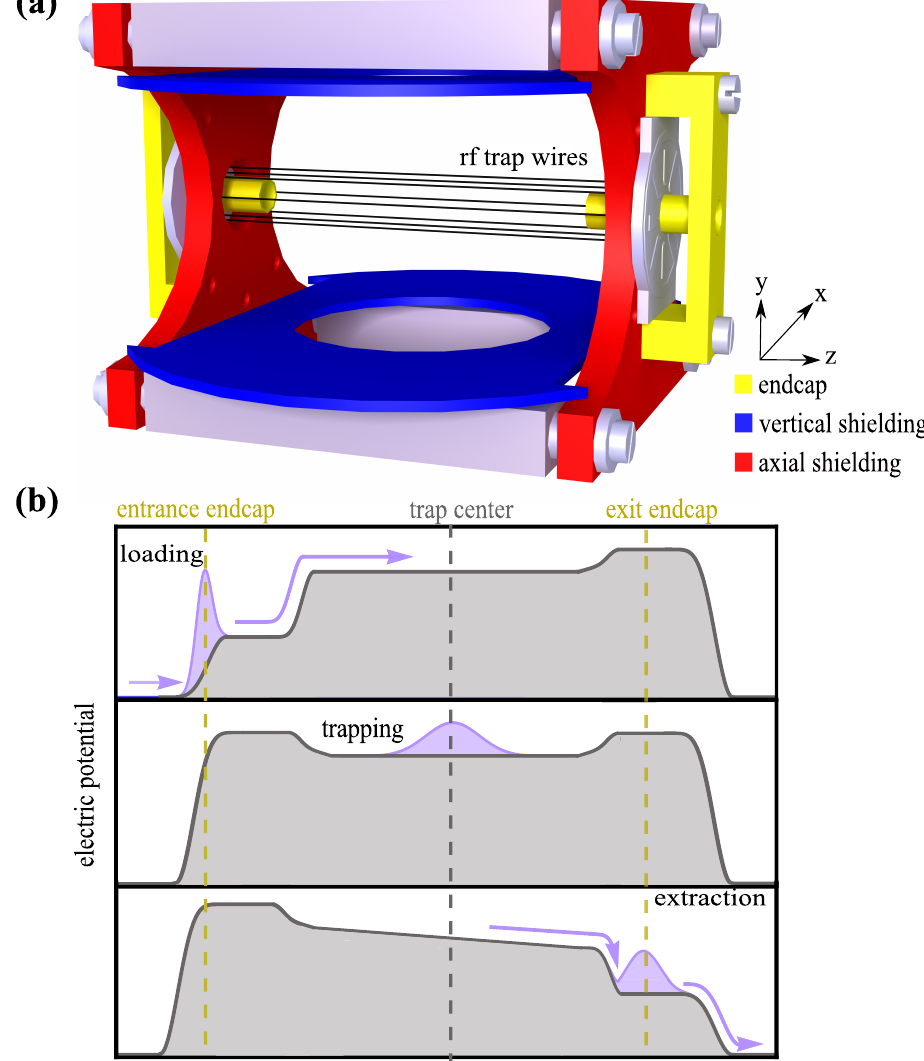
Figure 2. Description of the ion trap. ( a ) A 3D model of the ion trap is shown with an illustration of the radio frequency (rf) trap wires, endcap electrodes, and shielding plates used in the setup. ( b ) A qualitative description of the electric potential as a function of the position along the trap’s main axis during three different stages. Firstly, the loading of ions from the source into the trap. Secondly, the axial confinement of ions. Finally, the unloading of ions from the trap to be further extracted onto the